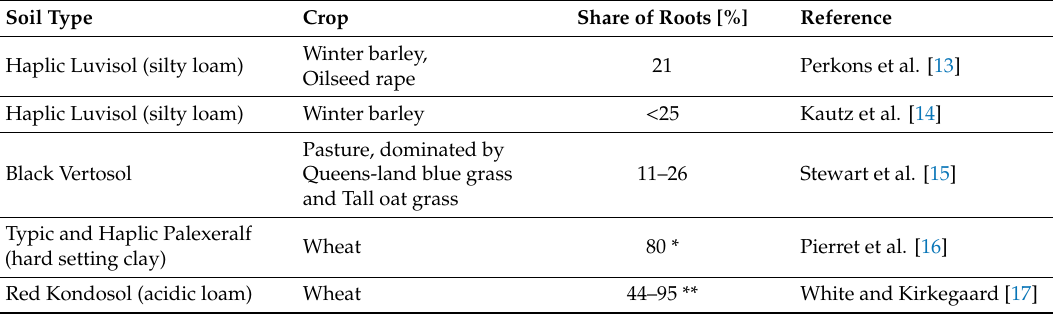
Table 1. The share of roots in biopores over the total root